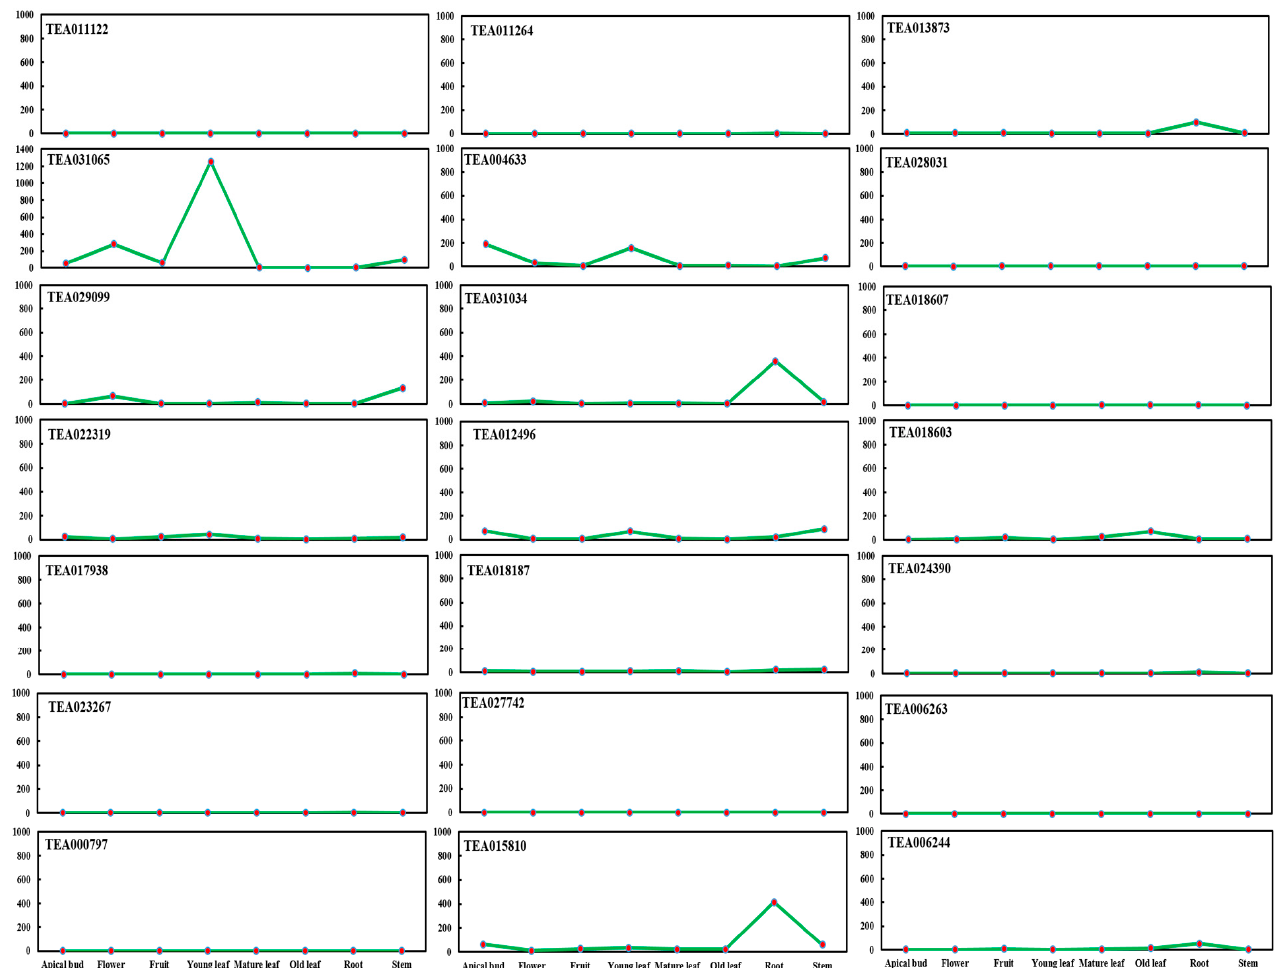
Figure 1. Expression of 21 BAHD Acyltransferase genes in tea ( C. sinensis ). Expression level of tea plant 21 BAHD acyltransferase genes at eight representative tissues (apical bud, flower, fruit, young leaf, mature leaf, old leaf, root, stem). The means of RNA-seq. analysis data are the ± SD ( n = 3) p < 0.05.